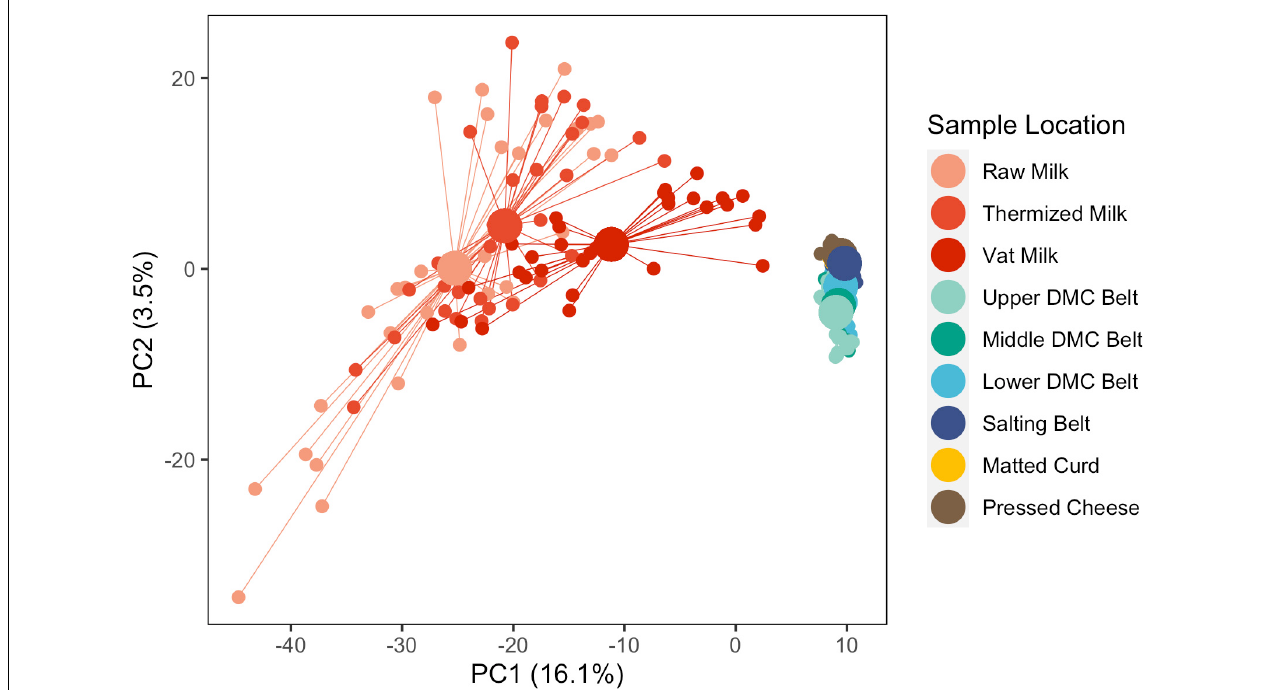
FIGURE 3 | Principle component analysis of microbial communities from all sample locations and all facilities, following clr transformation. Samples are grouped by sample location. Individual samples (small points) are connected by segments to their corresponding group centroids (large points). Sequence variants which explained at least 5% of the component variance include Clostridium (2 SVs), Peptostreptococcaceae (1 SV), Streptococcus (2 SVs), and Turicibacter (1 SV) for PC1, and Acinetobacter (1 SV) and Streptococcus (1 SV) for